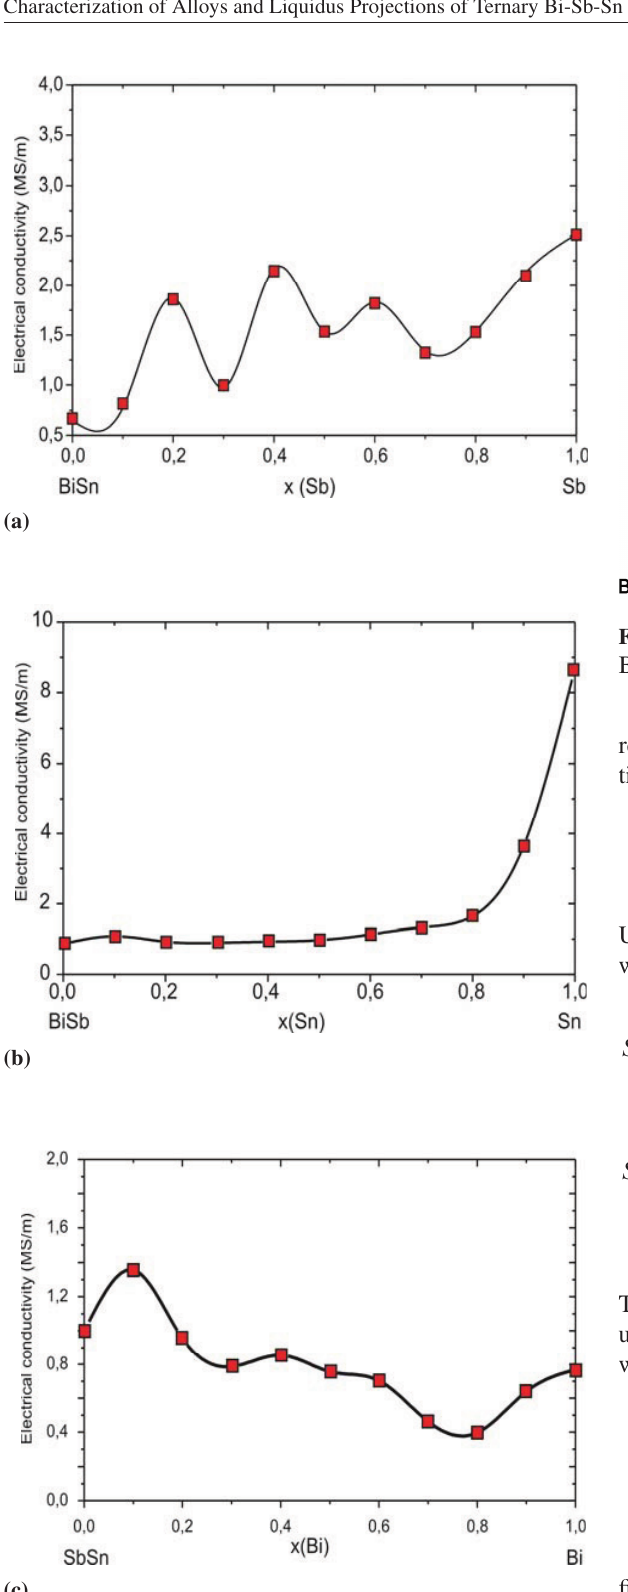
Figure 3. Electrical conductivity of ternary Bi-Sb-Sn sys- tem, (a) vertical BiSn-Sb section, (b) vertical BiSb-Sn sec- tion and (c) vertical SbSn-Bi section.